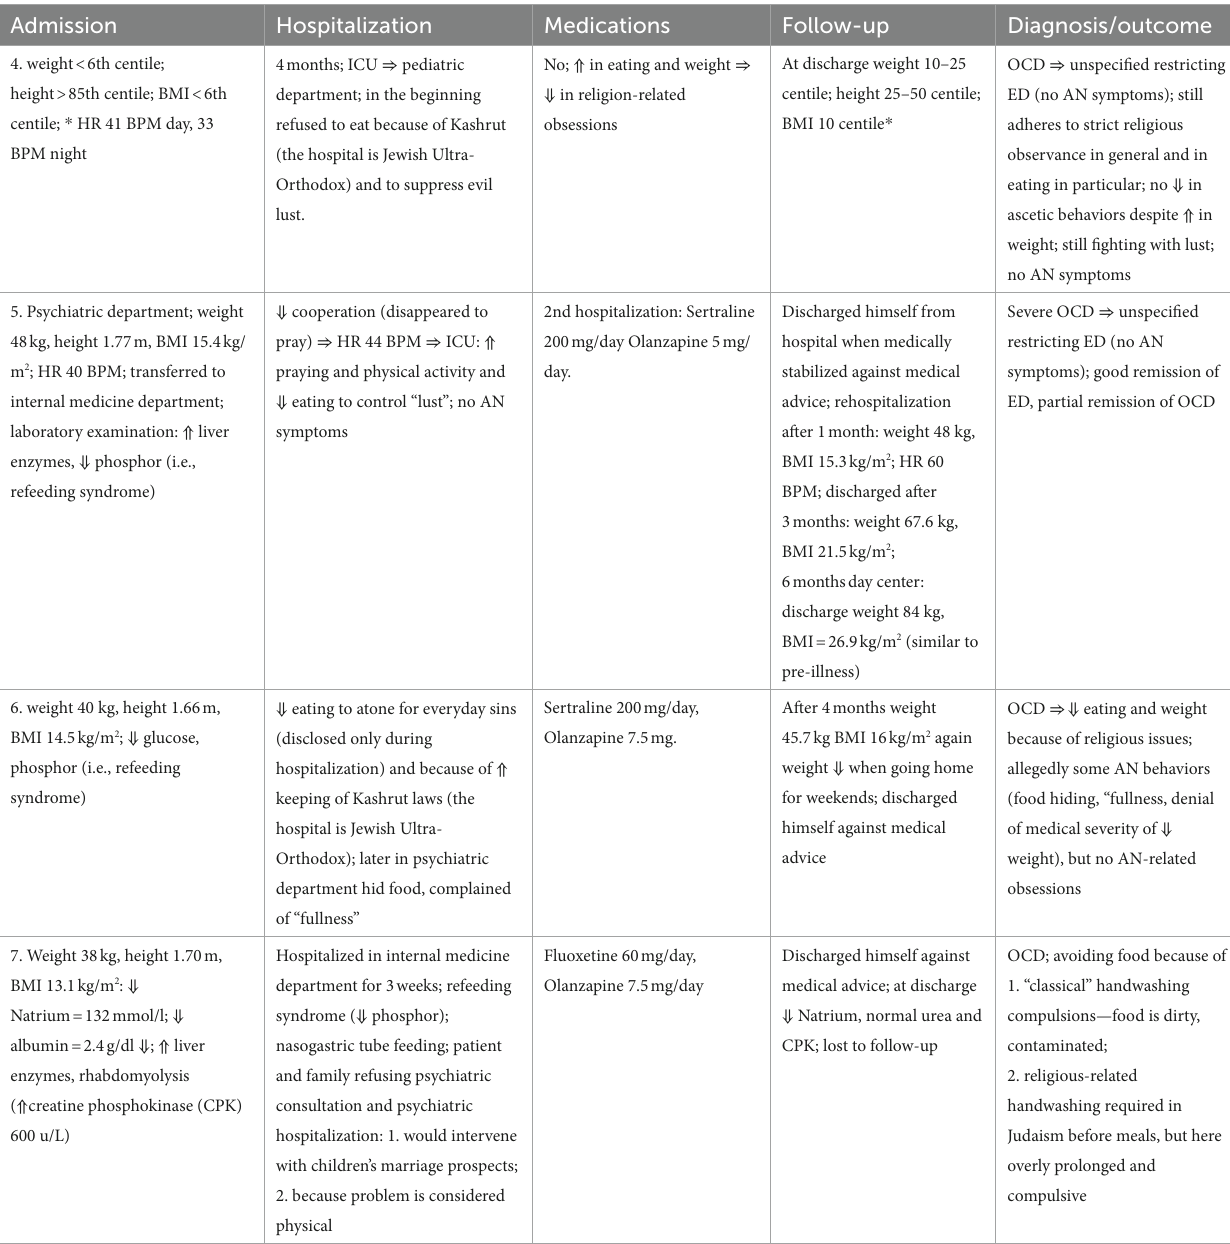
TABLE 4 One adolescent and three adults with DSM 5-TR unspecified restricting-type eating disorder resulting from OCD: admission, hospitalization, and post-hospitalization